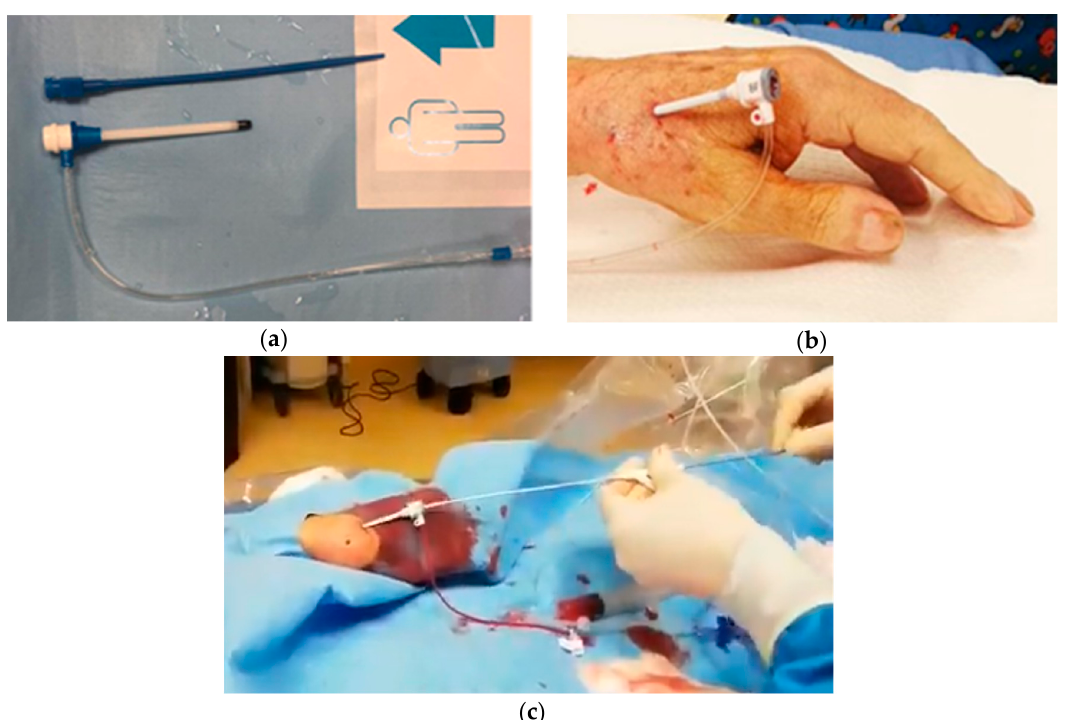
Figure 3. Vascular access for radial balloon aortic valvuloplasty. ( a ) Brite Tip 5.5 cm pediatric 8 French sheath (CORDIS, Ireland). ( b ) regular 11 cm 8F sheath, 5 cm out of the distal radial artery. ( c ) Vascular access for radial balloon aortic valvuloplasty: “Push and pull” maneuver for balloon retrieval.